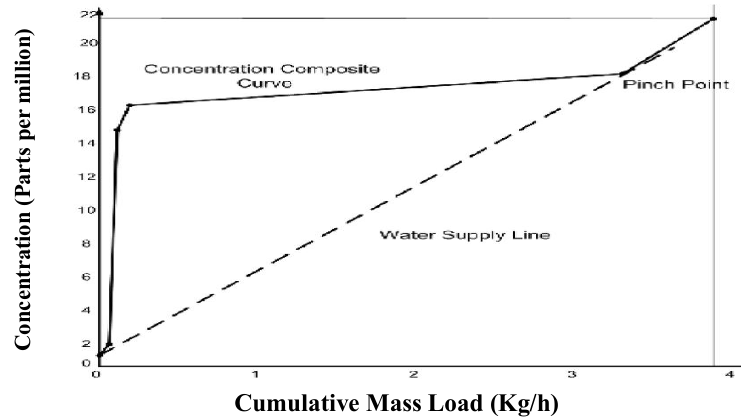
Figure 5 . The resulted curve from Mohammadnejad’s data (Mohammadnejad 2010 ).